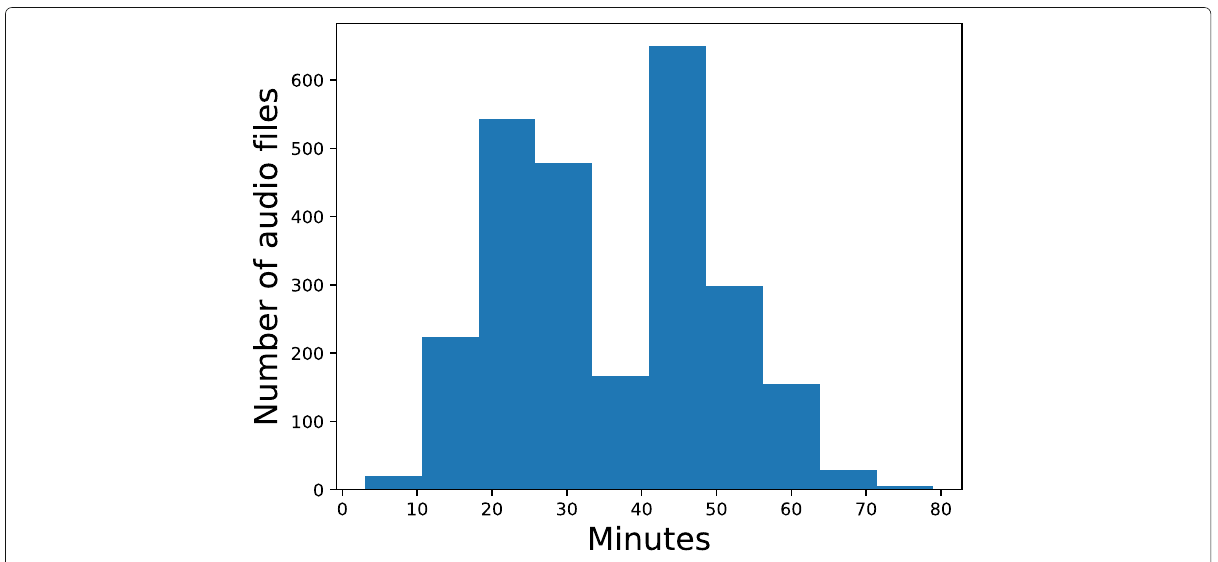
Fig. 3 The length distribution (min) of the TVSM-pseudo dataset